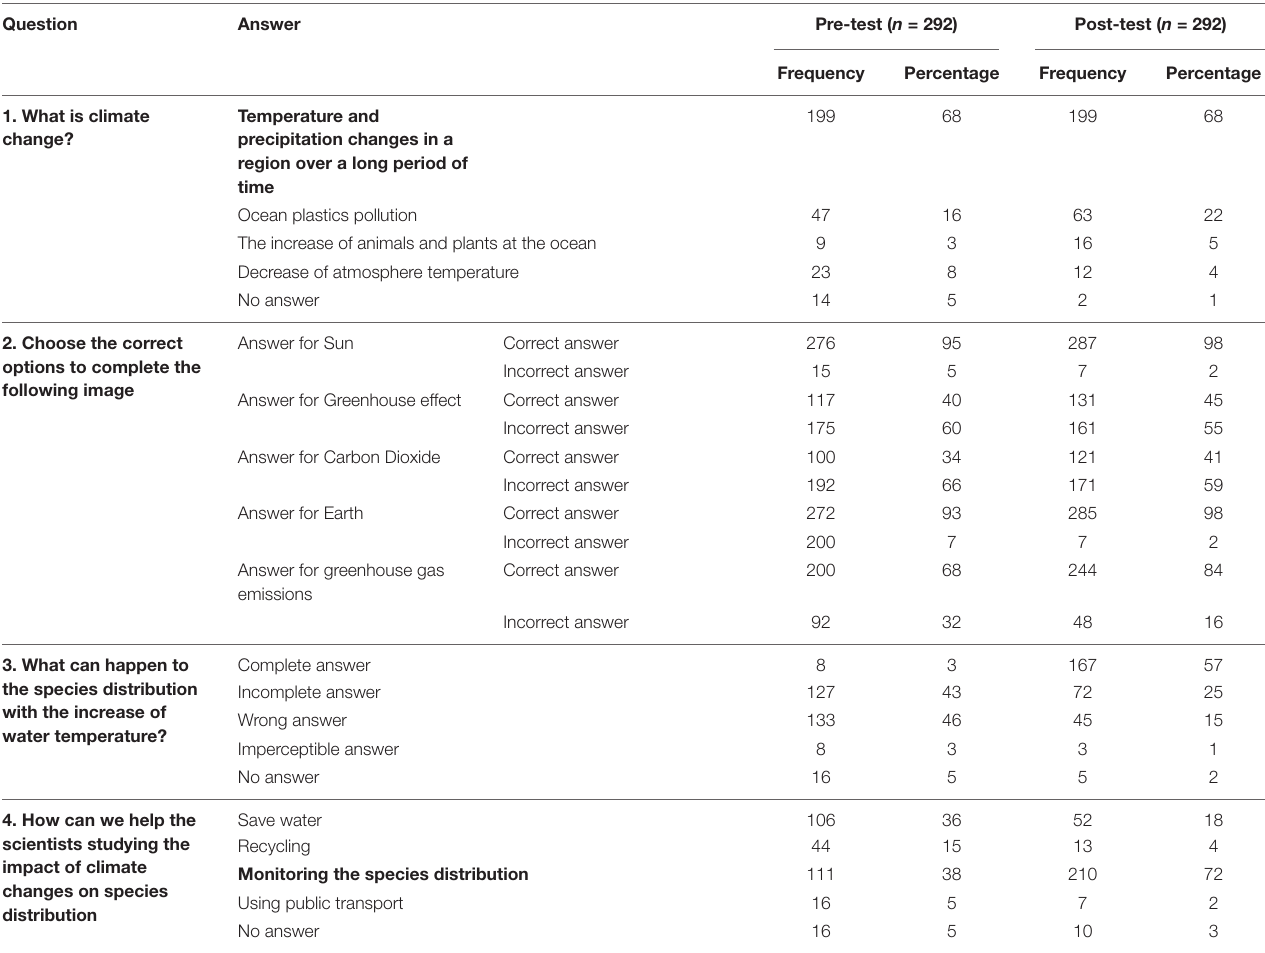
TABLE 2 | Pre- and post-test relative frequency and percentage results for each question.